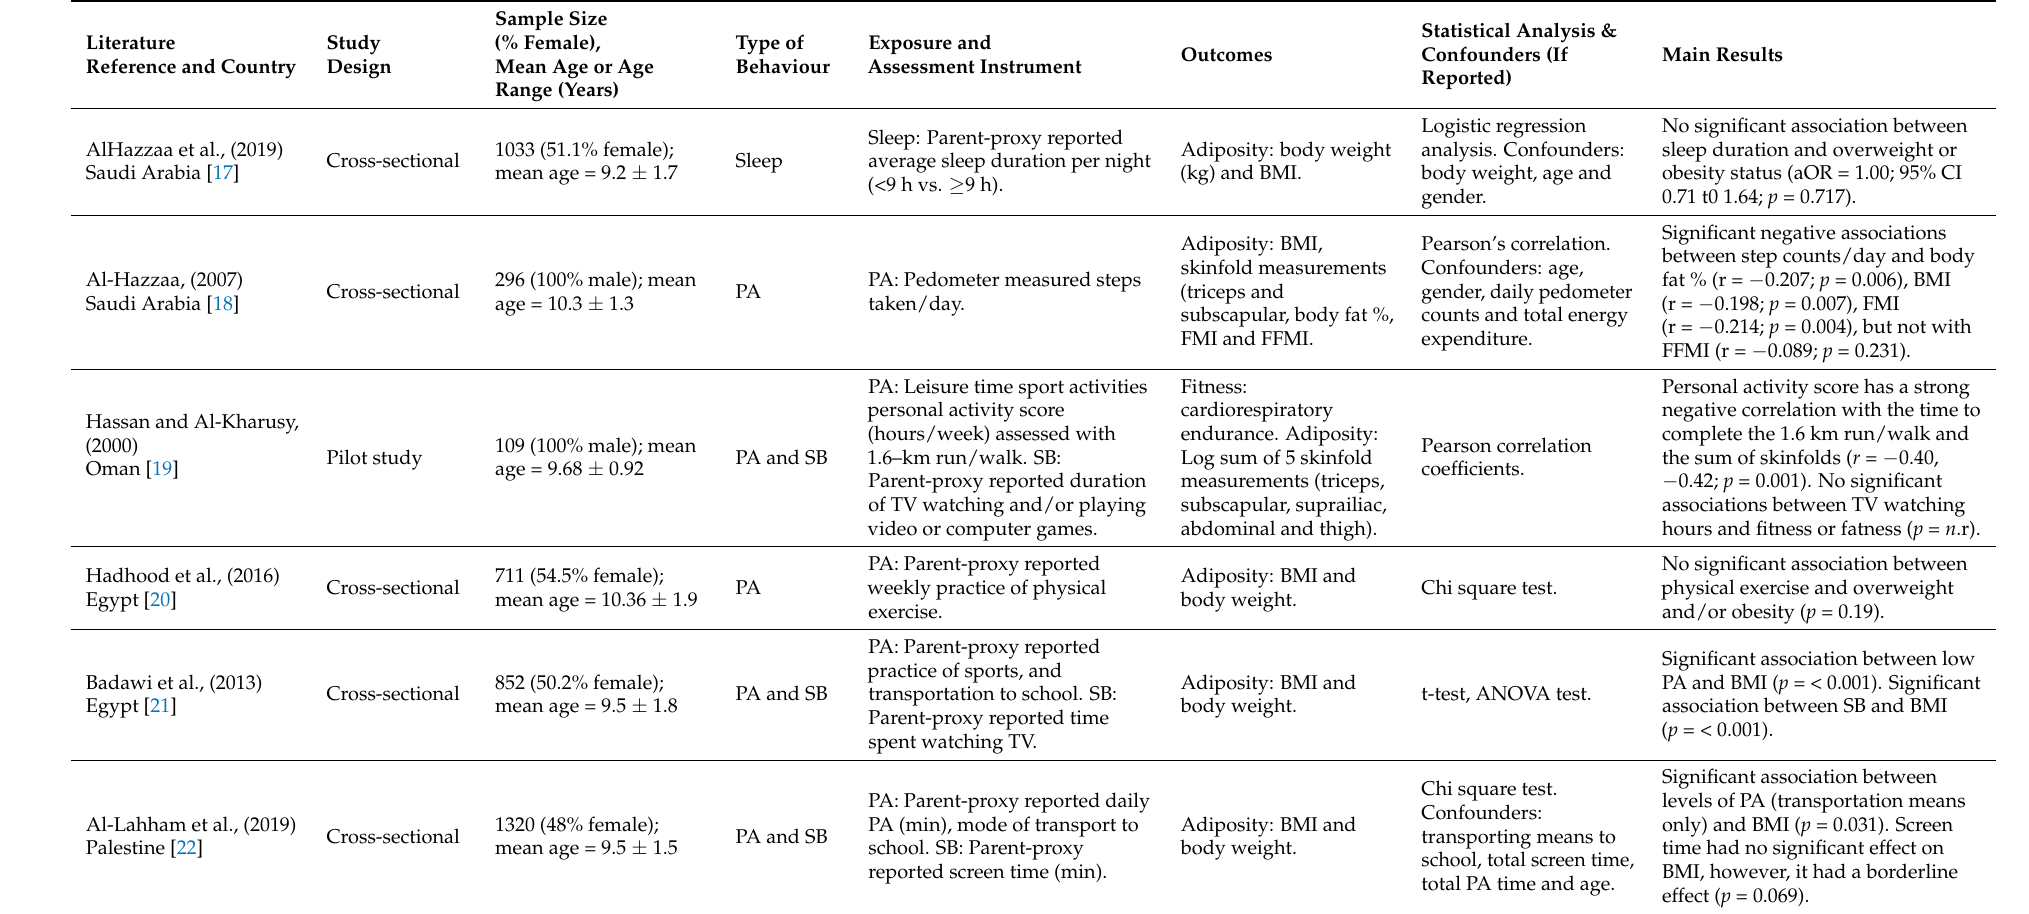
Table 1. Characteristics of included